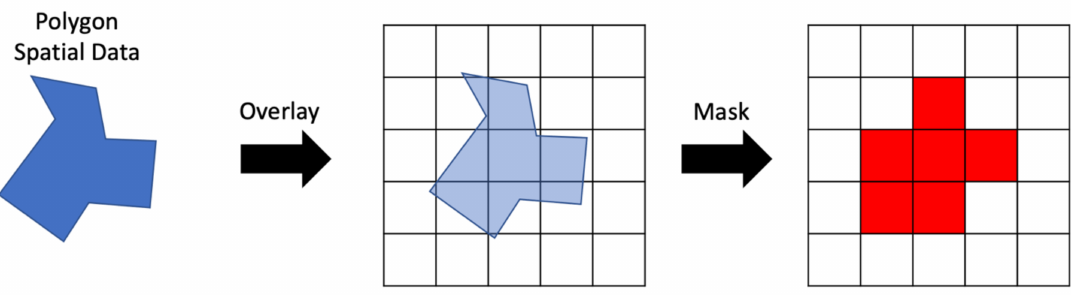
Figure 4. Creating a Raster Mask from Vector Data.